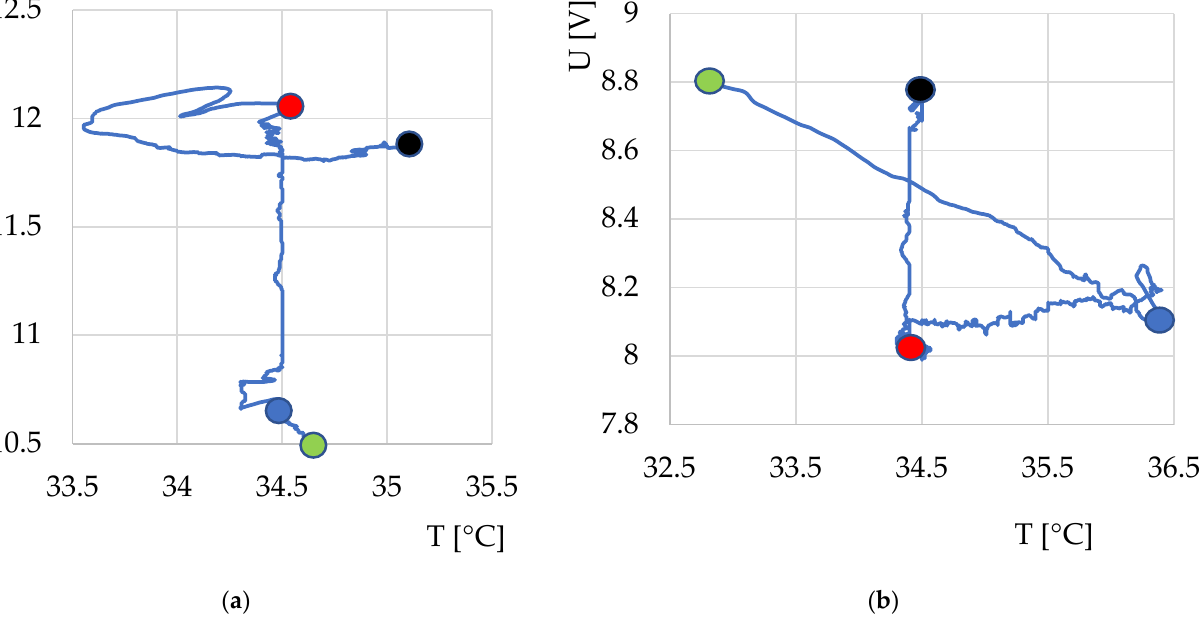
Figure 9. Courses of output voltage and temperature dependences during fermentation monitoring using thermodynamic system S1 for: ( a ) yoghurt without additives; ( b ) yogurt with the addition of insect flour. Description of points: green, start of measurement; blue, insertion of yogurt culture into milk or milk with additives; red, 6 h after the start of measurement (expected time of end of fermentation); black, end of measurement.